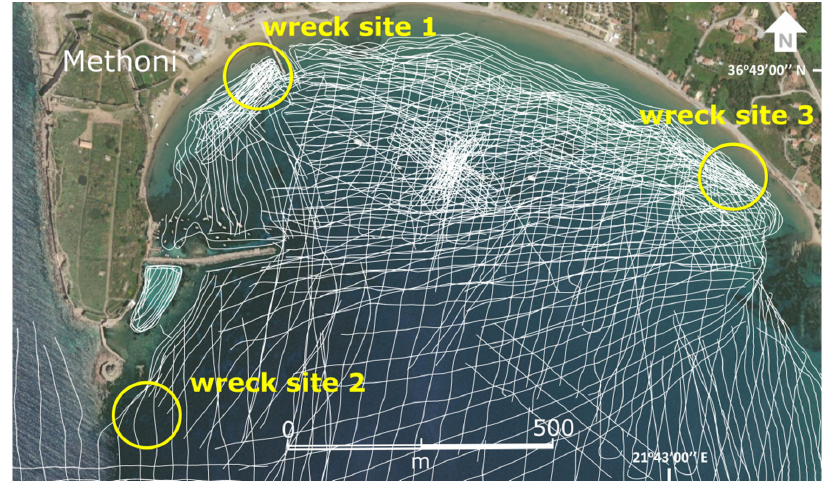
Figure 2. The marine geophysical survey track lines. Background map data source: Esri, Digital- Globe, GeoEye, Earthstar Geographics, CNES/Airbus DS, USDA, USGS, AeroGRID, IGN and the GIS User Community.